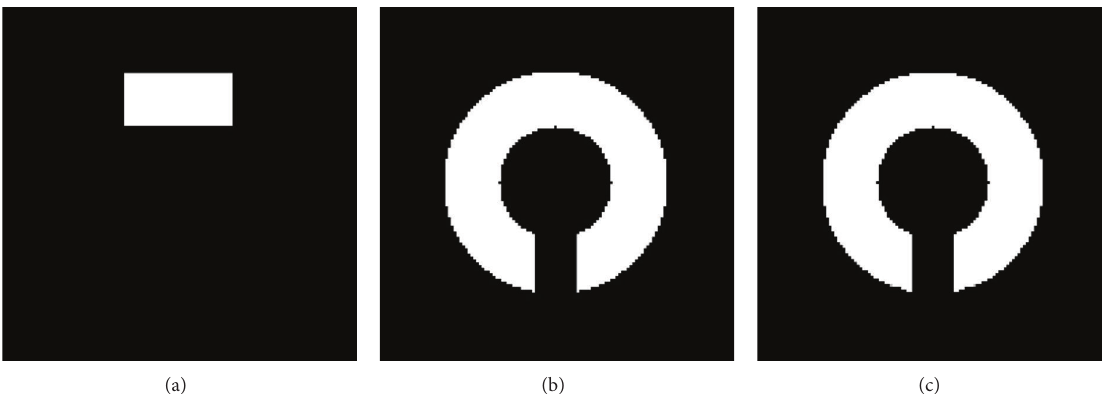
Figure 2: Results on 2D simulated datasets: (a) floating image, (b) target image, and (c) the result of Maxwell model with adaptive forces (MMAF).